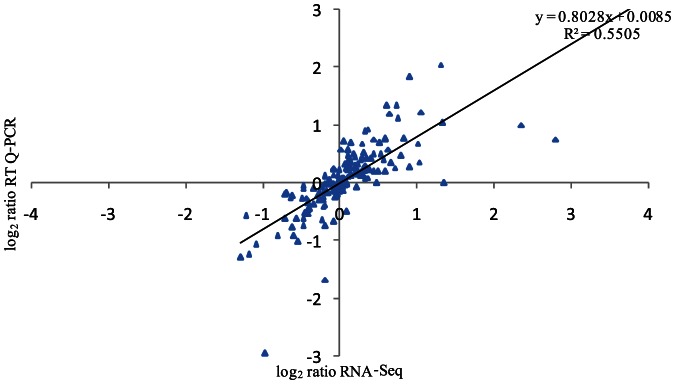
of RNA-Seq results by RT-qPCR.Plot of gene expression (fold change) determined by the RNA-Seq (Y-axis) and RT-qPCR (X-axis) for 167 selected genes (Pearson's correlation, R2 = 0.5505, P<0.01). The fold change was expressed as log2 values.